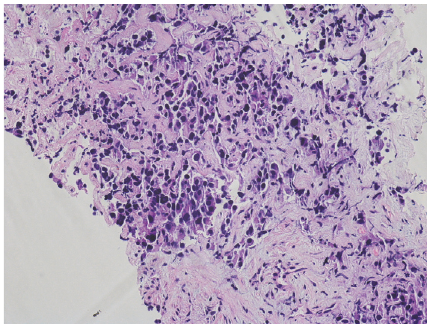
Figure 3: H&E stain from liver biopsy with morphologically similar cells to the esophagus biopsy.